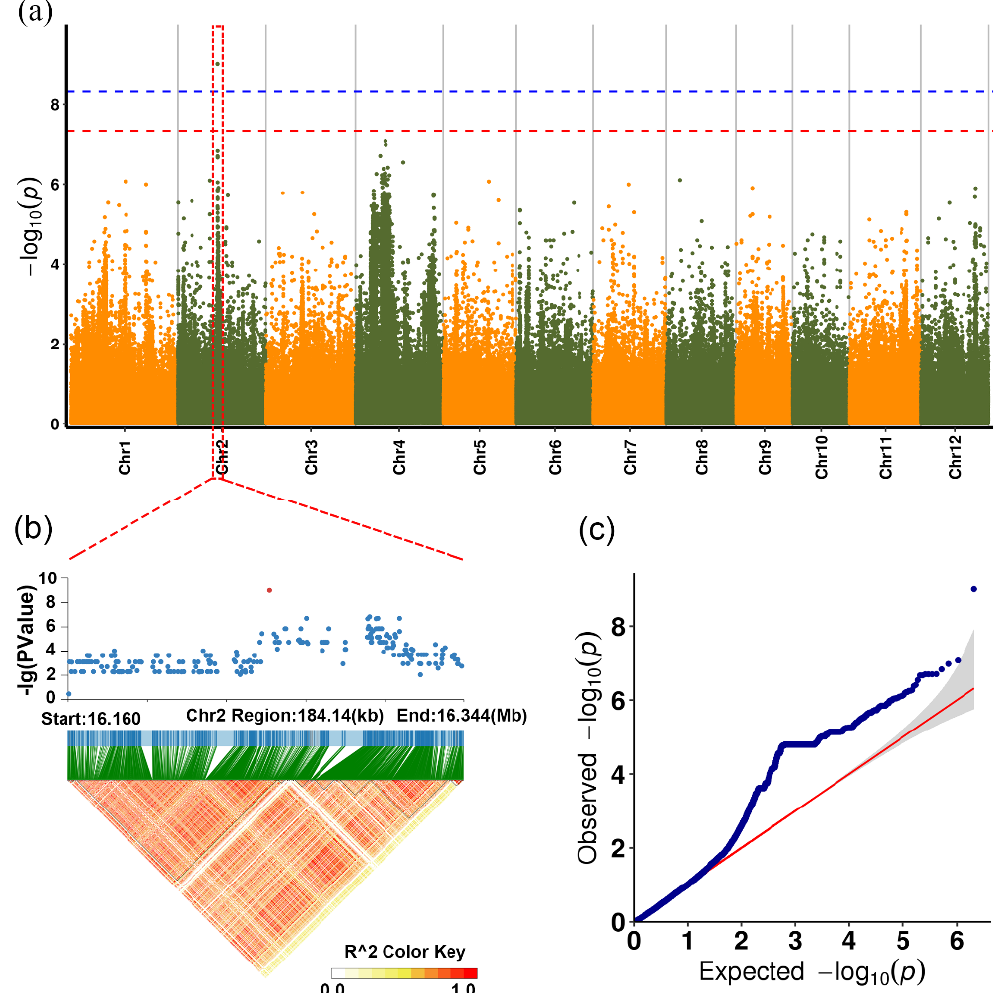
Figure 4. Manhattan plot of genome association analysis and linkage disequilibrium block analysis. ( a ) Manhattan plot of FaST-LMM association mapping. ( b ) LD block module analysis of chromosome 2. ( c ) Graph of expected and observed p values.